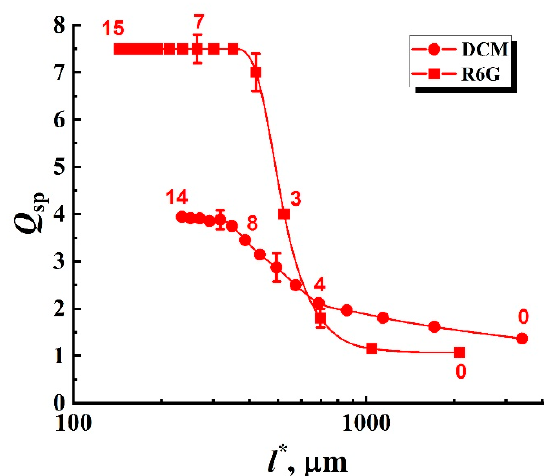
Figure 5. Q sp values against the MTFP values for the R6G- and DCM-based suspensions (samples #2). Selectively shown error bars correspond to a confidence level of 0.9.